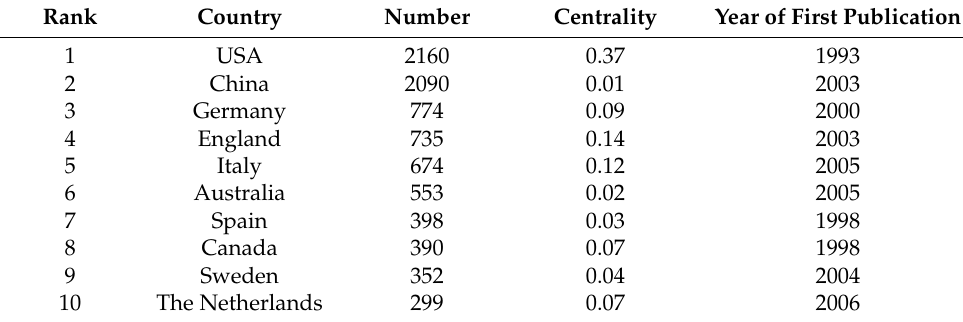
Figure 4. Knowledge map of cooperative countries or regions in the research on UES during 1991–2022. Table 2. List of contributing countries or regions and number of records contributed.